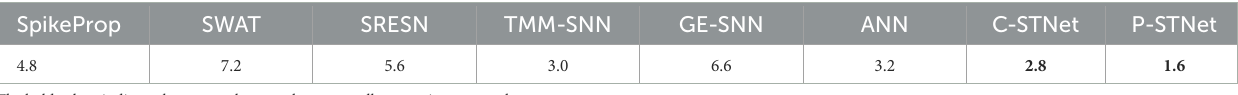
TABLE 4 Average rankings of the test accuracies for the eight approaches on the six small datasets.